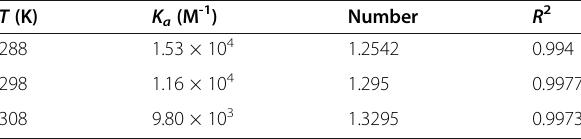
Table 2 The binding constant K a value and the number of binding sites n between PHL and